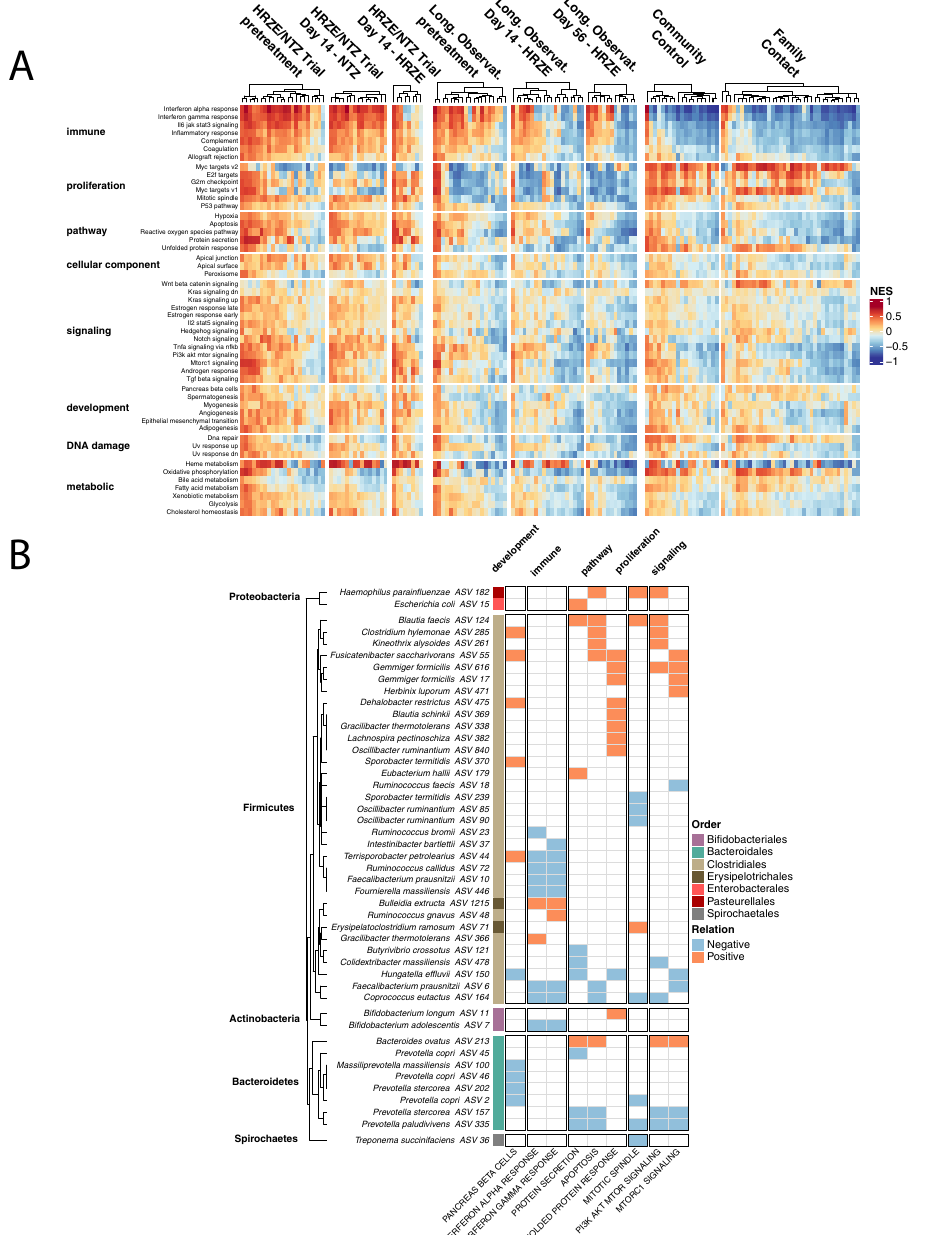
Fig. 7 Analysis of microbiome and blood peripheral gene expression in an independent healthy control human cohort validates association between speci fi c microbiome members and host peripheral gene expression. A NES scores of 50 Hallmark pathways from the MiSigDB on a per-sample basis for all cohorts in this study. NES score was calculated using the variance stabilized transformed counts from DSEeq, calculated with the GSVA package in R, and plotted after scaling ( Z score) across all samples. Columns are split based on arm or group membership and rows are split based on Hallmark pathway categorization. B Random forest regression results associating speci fi c microbial taxa with Hallmark pathways. Only pathways identi fi ed in the RFR model are shown. The ‘ Relation ’ , calculated by taking the fi rst derivative of the ALE plot for each relationship, is positive if the pathway positively associates with a particular ASV, or negative if the pathway negatively associates with a particular ASV. Source data are provided as a Source Data fi